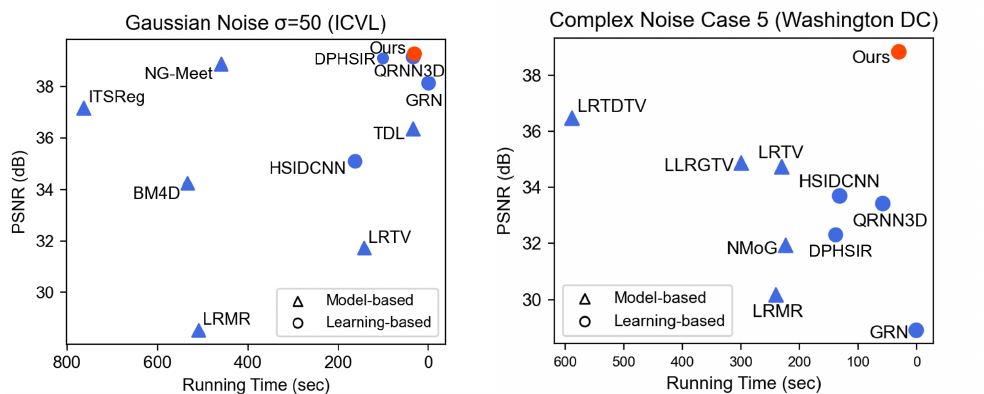
Figure 1. Quantitative comparisons (PSNR (dB) vs. running speed (second)) of our DIBD against other competitive approaches on the ICVL and Washington DC